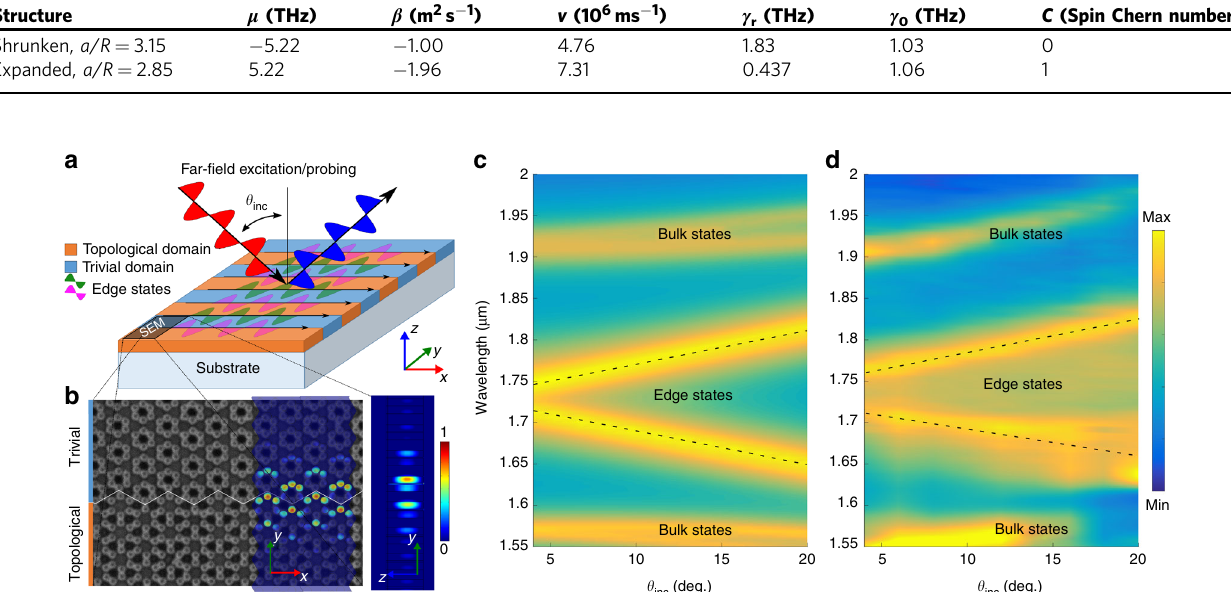
Fig. 4 Far- fi eld spectroscopy of topological edge states. a Schematic optical setup for far- fi eld mapping of photonic bands corresponding to edge states in a topological meta-grating. Meta-grating is formed by stitching 12 unit cells of alternating topological/expanded (orange) and trivial/shrunken (light blue) domains of the metasurface with 30 domain walls in total. b SEM image of the proximity to one of the domain walls overlaid with the computed fi eld pro fi le (electromagnetic energy density) of the edge state. c The results of CMT calculations of the scattering from topological meta-grating. Periodic conditions are imposed on the outer interfaces. d Measured far- fi eld re fl ectance spectra revealing edge states within the bulk bandgap. The parameters used in CMT model are: on-site energy ω 0 = 173.61 THz, intra-cell tunneling amplitude K = 33.00 THz, inter-cell tunneling amplitude J = 23.00 THz, radiative loss γ r = 0.25 THz, and non-radiative loss γ 0 = 0.30 THz